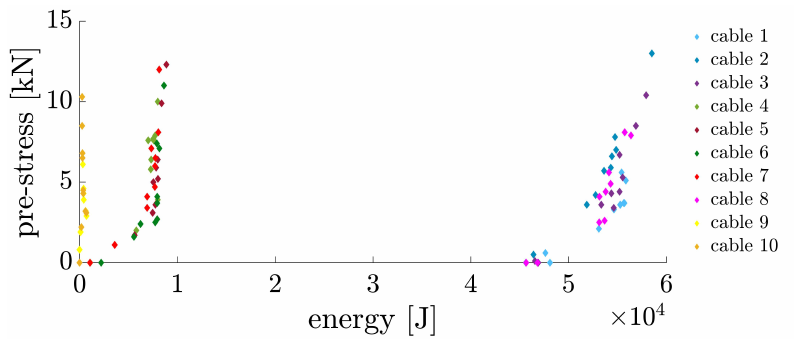
Figure 21. Locally dissipated energy according to prestress in each cable.